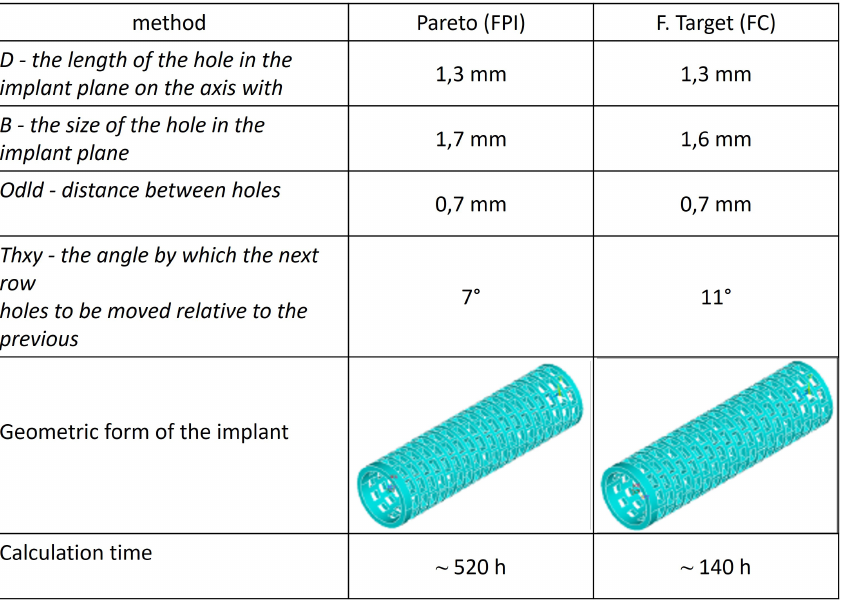
Figure 17. Comparison of geometric features obtained with both methods for the FPI and FC